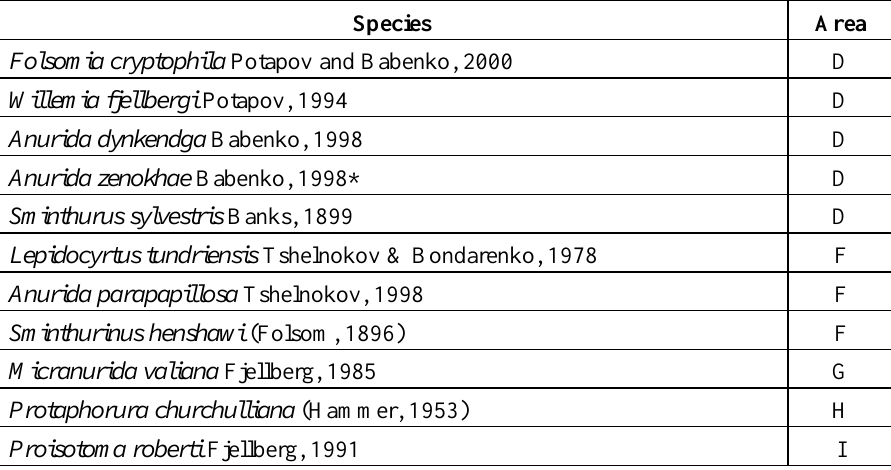
Table 3. List of restricted or endemic species and the area where they occur (*described as Palaearctic but has only been described from the Yenisey river